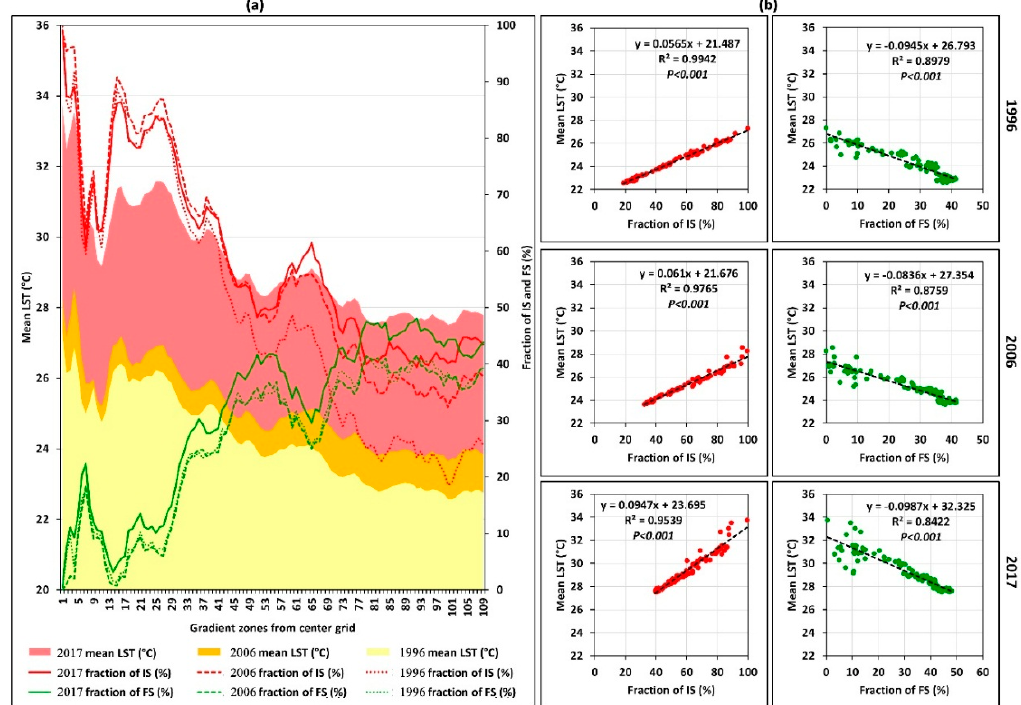
Figure 3. ( a ) Spatial pattern of mean LST and the fraction of IS and FS along the gradient zones (GZs); and ( b ) scatter plots between mean LST and fraction of IS and FS in 1996, 2006, and 2017.